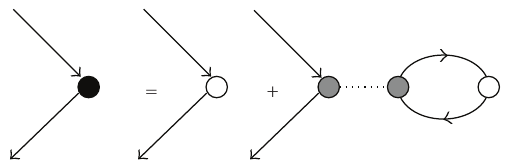
Figure 1: Leading-order in 1 /N diagrammatic structure of the e ff ective e-ph vertex dressed by electronic processes only: the dashed line is the slave-boson propagator only involving b and λ bosons (pure e-e interaction), the solid dot is the dressed e-ph vertex, the open dots are the bare e-ph vertices and the grey dots are the quasiparticle-slave-boson vertices.